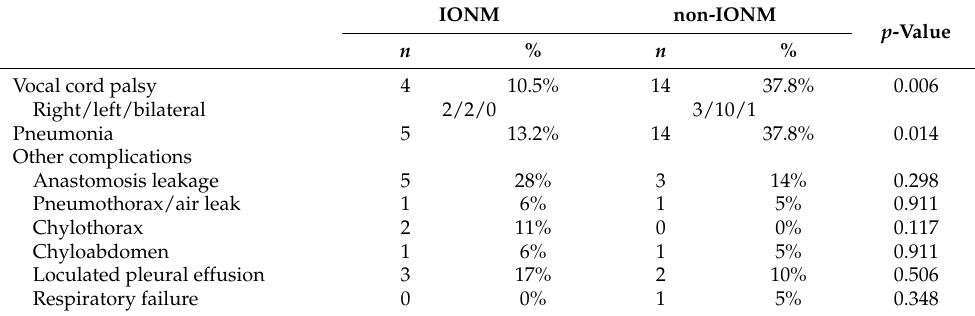
Table 3. Postoeprative